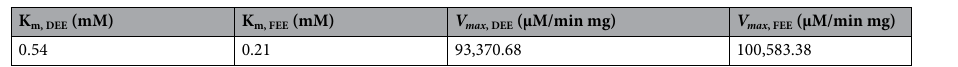
Table 5. The obtained kinetic parameters of the dried extracted enzyme (DEE) and freshly extracted enzyme (FEE).